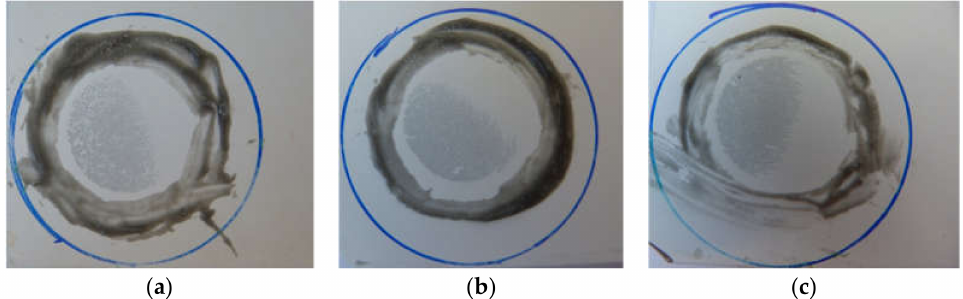
Figure 16. Appearance of the surface affected by the adhesion test area performed after the temperature cycling test, for ( a ) the sample with sand from Ouarzazate, ( b ) the sample with sand from Dubai, and ( c ) the sample without sand.